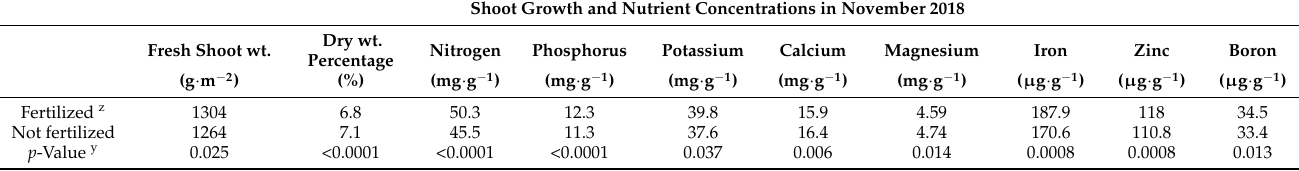
Table 2. Microgreen shoot growth and nutrient concentrations on a dry weight basis affected by fertilization in Novem- ber 2018. Shoot Growth and Nutrient Concentrations in November 2018 Fresh Shoot wt. Dry wt. Percentage